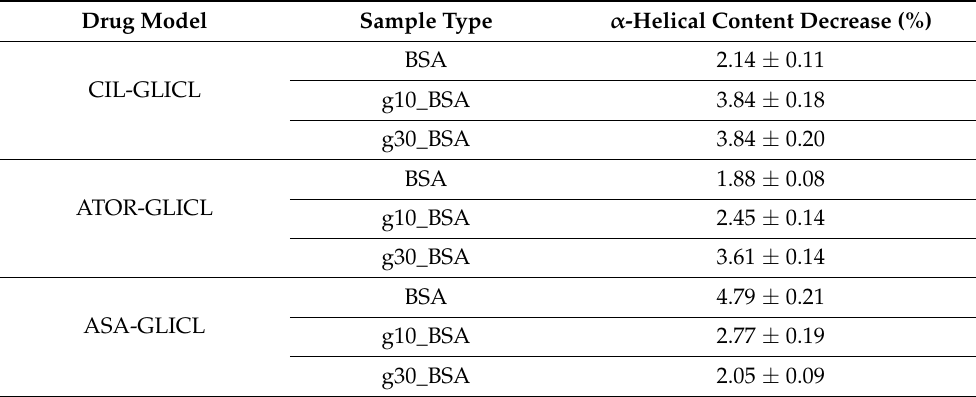
Figure 6. Circular dichroism spectra of protein (2 µ M): native BSA, g10_BSA, g30_BSA with CIL (8 µ M) and GLICL (14 µ M), pH 7.4. Table 2. The percentage of changes (mean ± SD) to the α -helical structure of native and glycated BSA-GLICL complexes before and after interaction with DRUG (CIL, ATOR, ASA).